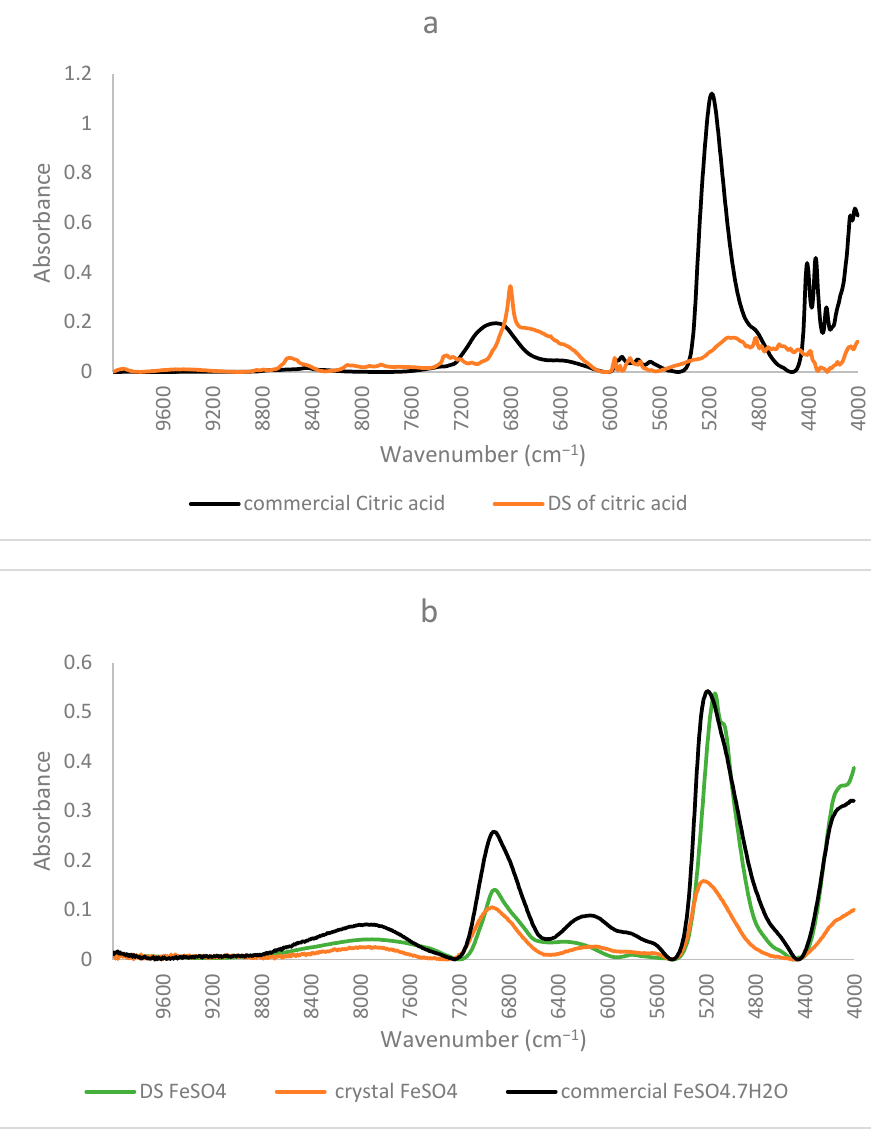
Figure 4 . NIR spectra of commercial form and the dried solution of ( a ) citric acid; ( b ) iron sulfate with obtained crystal .